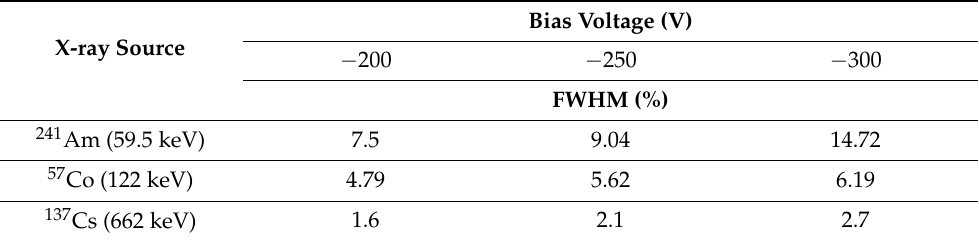
Table 2. Energy resolutions of the In/CdTe/Au p-n junction detector, fabricated by laser radiation of the In electrode, measured at different bias voltages for three X/ γ -ray radiation sources. Bias Voltage (V) X-ray Source − 200 − 250 − 300 FWHM (%) 241 Am (59.5